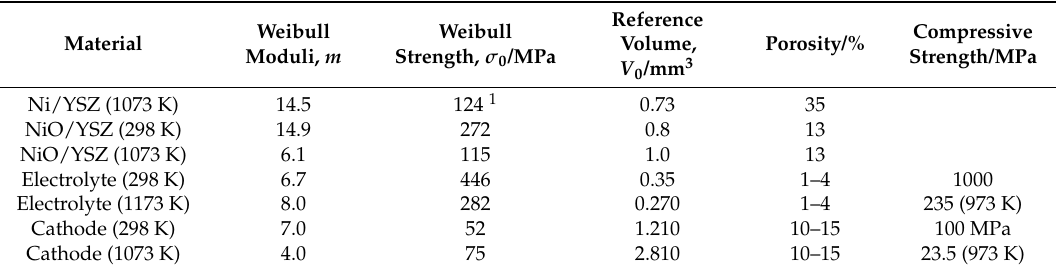
Table 2. Weibull parameters and compressive strengths of solid oxide fuel cell (SOFC) materials